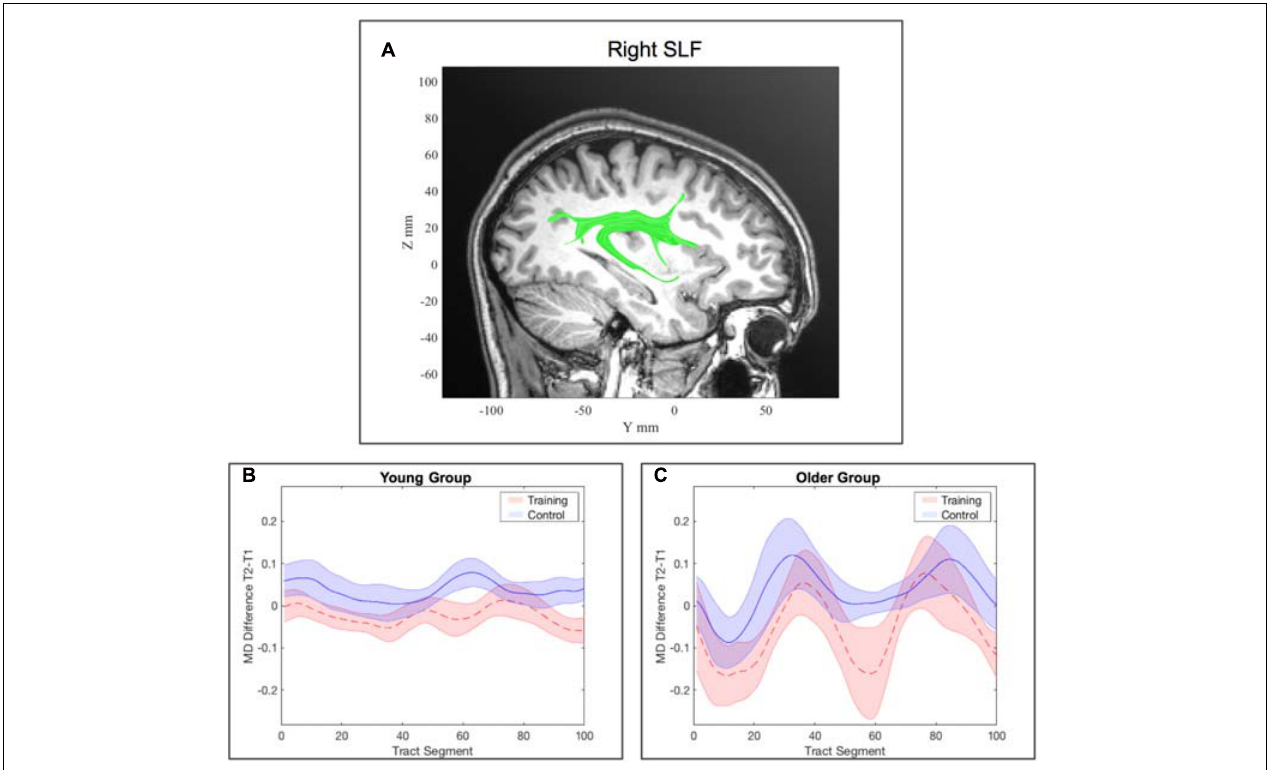
FIGURE 7 | Tract-wise averaged mean diffusivity in the right superior longitudinal fasciculus (SLF). (A) location of the right SLF. (B) change in MD from pre- to post-assessment along the tract segments for the young WM group and young AC group separately. (C) change in MD from pre- to post-assessment along the tract segments for the older WM group and older AC group separately. Note: the shaded areas represent the standard error, whereas the lines show the mean across all participants within the corresponding